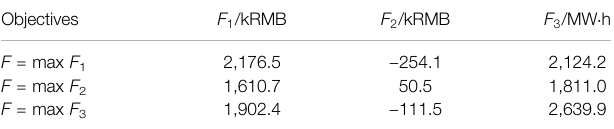
TABLE 5 | Function values with different optimization objectives.